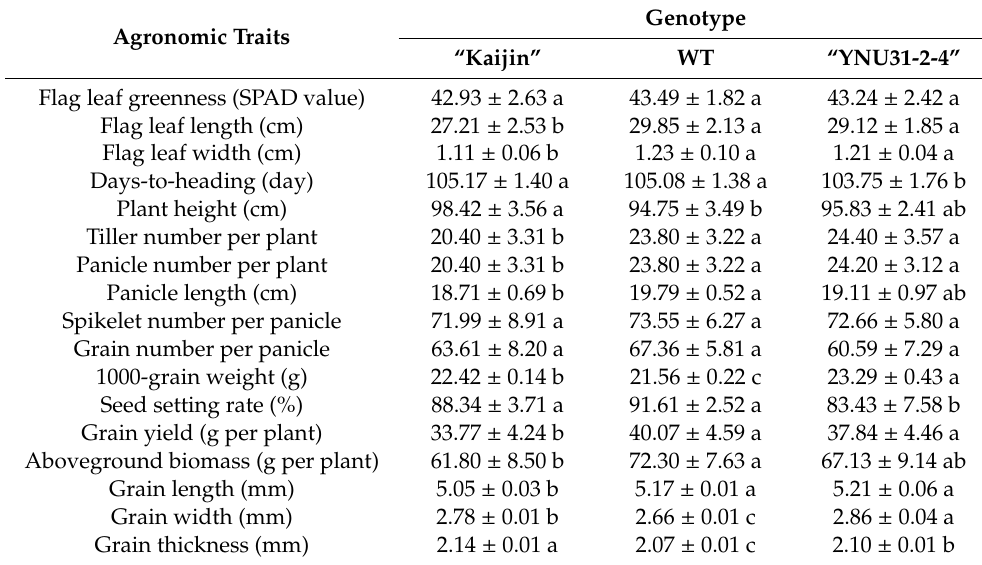
Table 3. Growth and yield performance of “Kaijin”, WT, and “YNU31-2-4” genotypes under normal field conditions. Grain yield is weight of filled spikelets at 14% moisture content. Data are mean ± SD ( n = 10–12). Values with the same letter within a row are not statistically di ff erent (Duncan’s multiple range test, p <